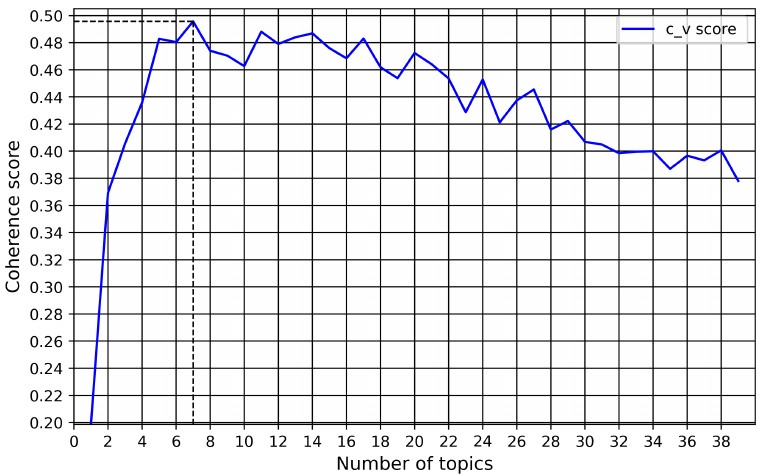
Figure 6. LDA model selected for its analysis.